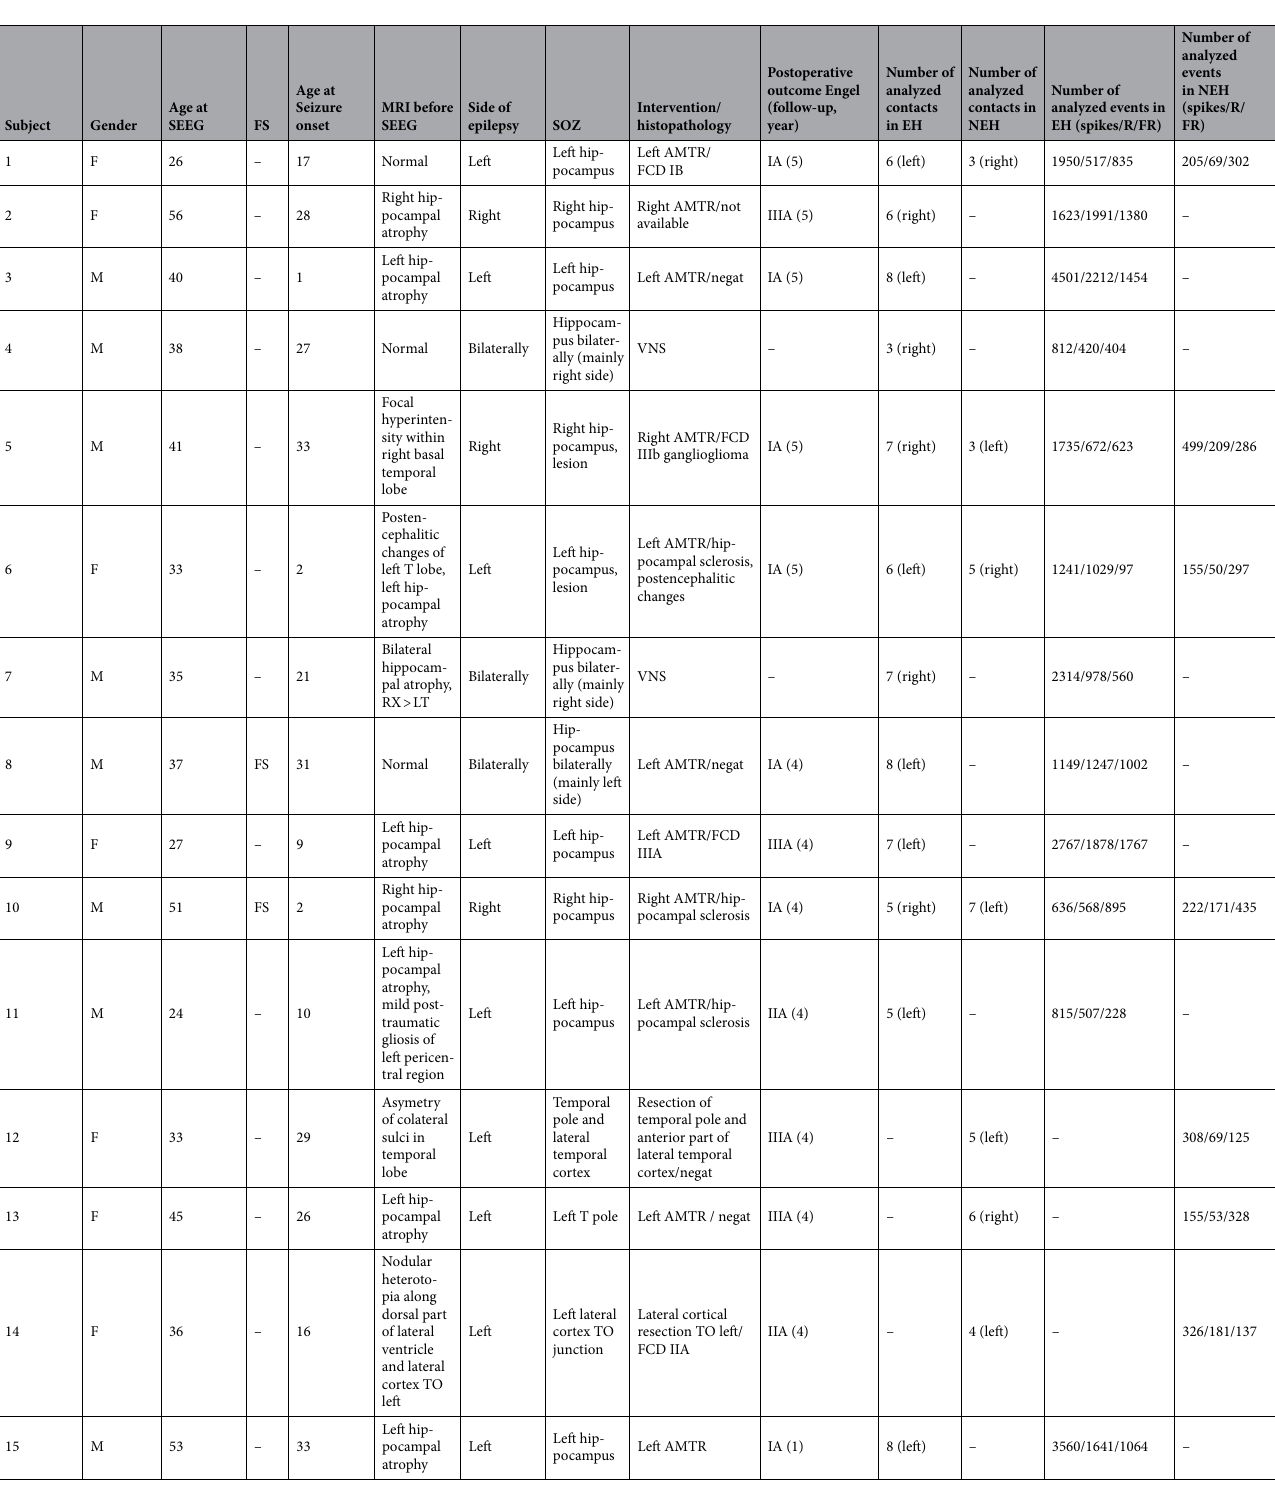
Table 1. Demographic and clinical data. M = male, F = female; SEEG = stereoelectroencephalography; T = temporal; O = occipital; FS = febrile seizures; SOZ = seizure onset zone; AMTR = anteromedial